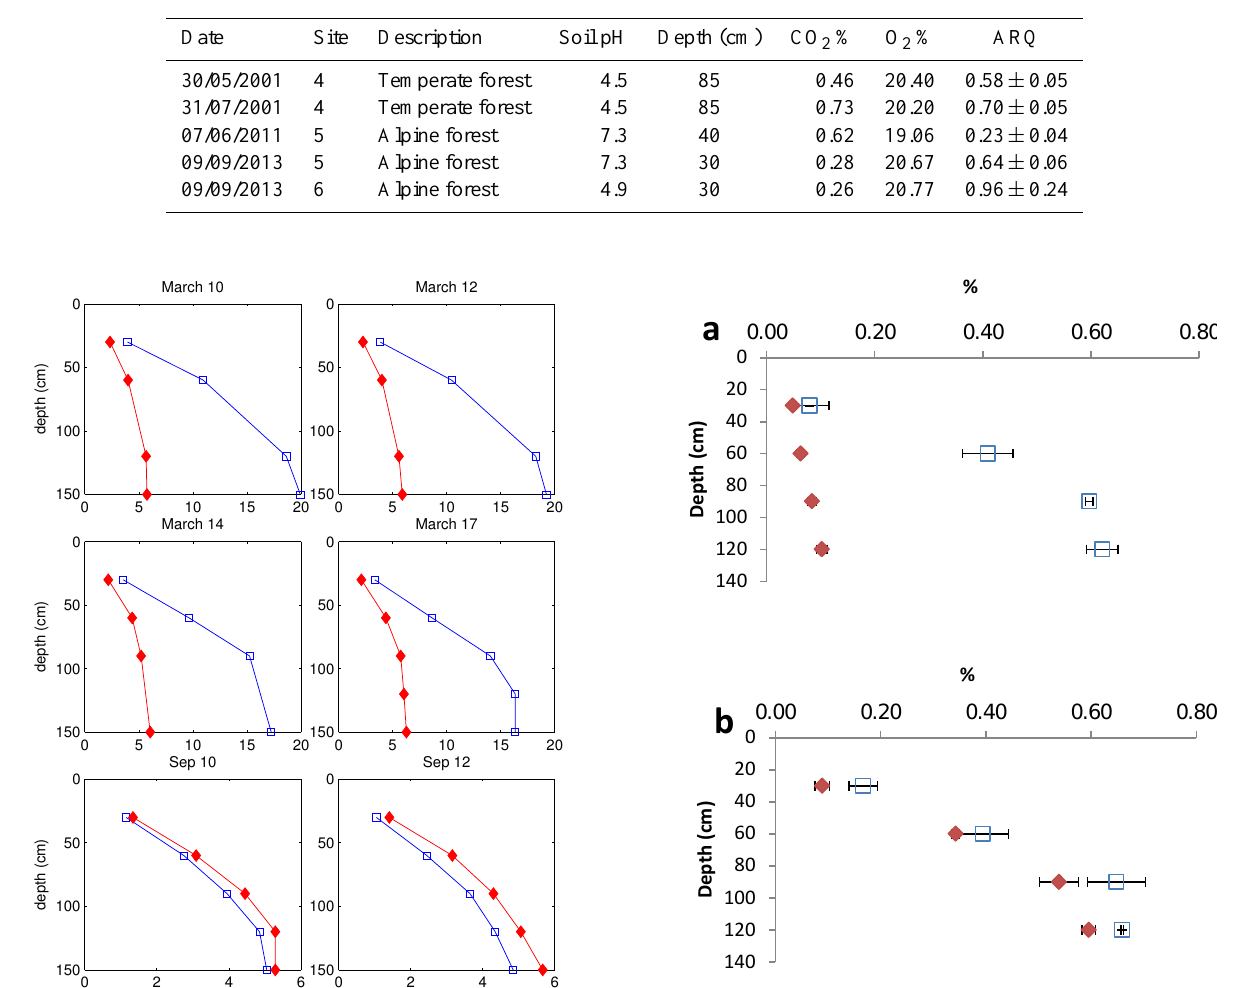
Figure 2. The − (cid:49) O 2 (open blue squares, O 2 decrease from am- bient) and 0.76 (cid:49) CO 2 (red diamonds, CO 2 increase above ambient corrected for lower gas diffusivity compared to O 2 ) profiles in the soil of site 2 (semiarid pine forest) in January (a) and April (b) . The values are in percent (same units as in Fig. 1, but note that the con- centration changes here are lower by 1 order of magnitude than in Fig. 1). Some error bars are smaller than the